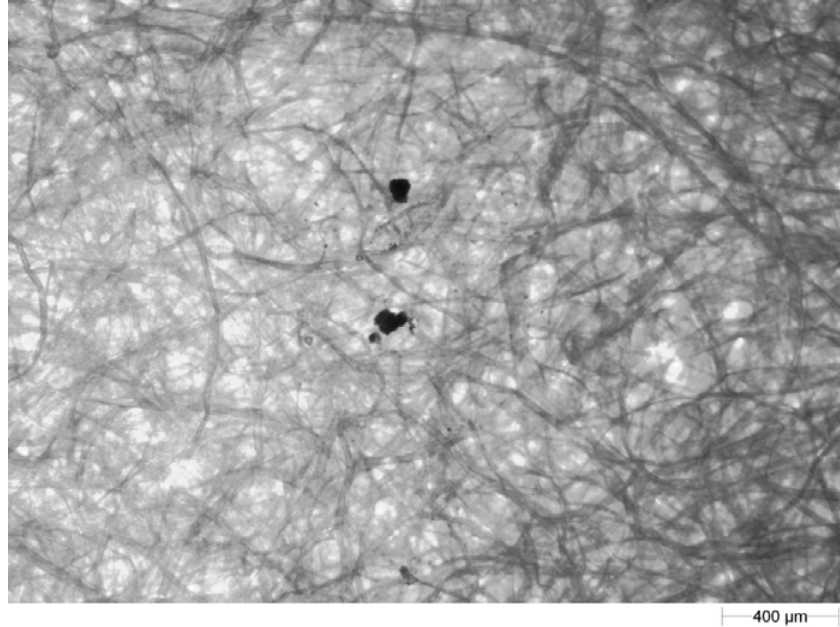
Figure 9. An example image of loose particles recorded on blotting paper.